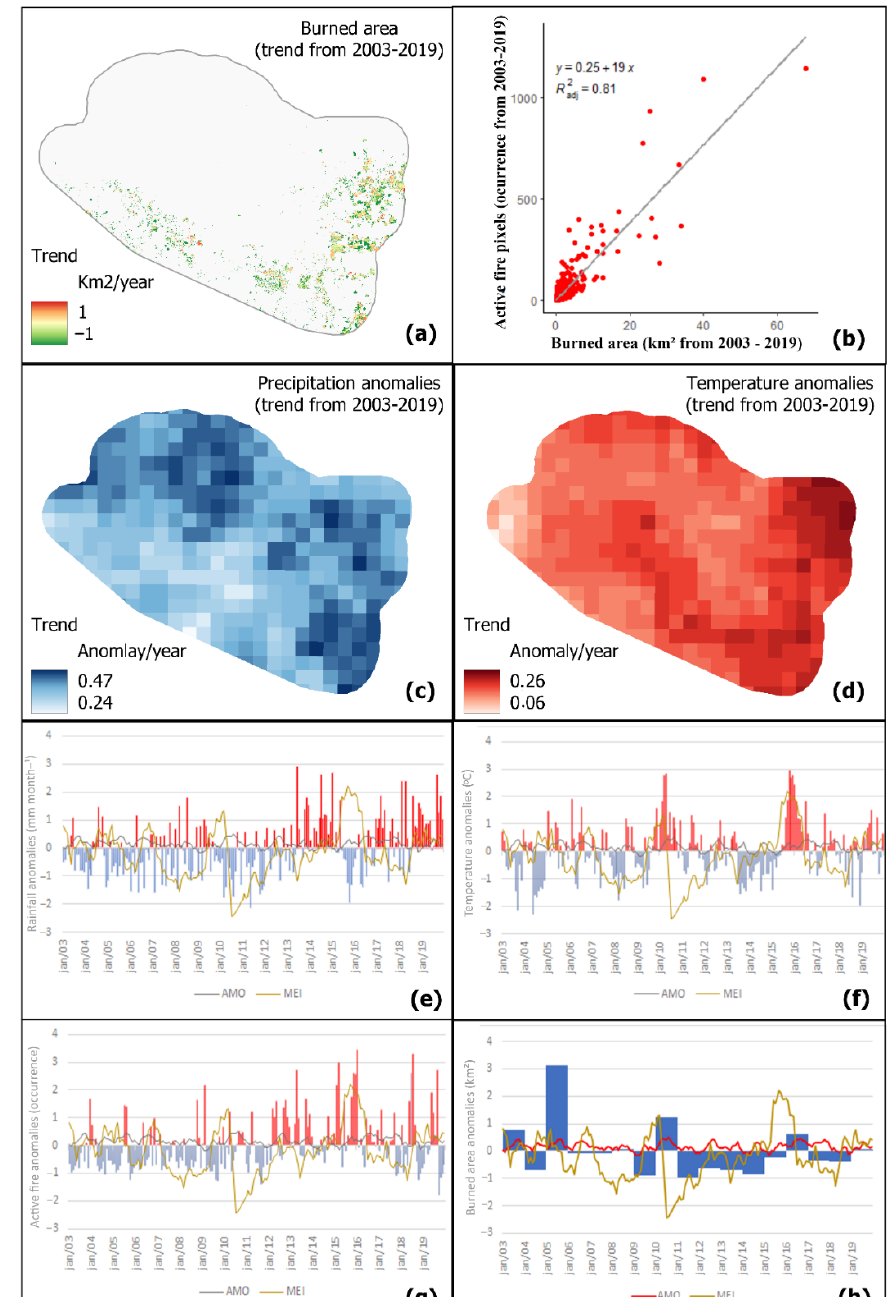
Figure 3. Climate analysis of the study region, showing ( a ) Spatial trends for each burned area (30 m spatial resolution) between 2003 and 2019, negative values (in green) represent decreasing trends, while positive values (in red) represent increasing trends. ( b ) Linear Regression analysis between active fire pixels and burned area, where R²adj is the adjusted coefficient of determination. ( c ) Spatial trends for each rainfall anomaly (30 m spatial resolution) between 2003 and 2019. ( d ) Spatial trends for each temperature anomaly (30 m spatial resolution) between 2003 and 2019. ( e ) Temporal patterns of oceanic indices (AMO and MEI) and their influence on rainfall anomalies for the period from 2003 to 2019. ( f ) Temporal patterns of oceanic indices (AMO and MEI) and their influence on temperature anomalies for the period from 2003 to 2019. ( g ) Temporal patterns of oceanic indices (AMO and MEI) and their influence active fire anomalies for the period from 2003 to 2019. ( h ) Temporal patterns of oceanic indices (AMO and MEI) and their influence burned area for the period from 2003 to 2019. Red and blue bars indicate positive and negative anomalies, respectively, for all variables.